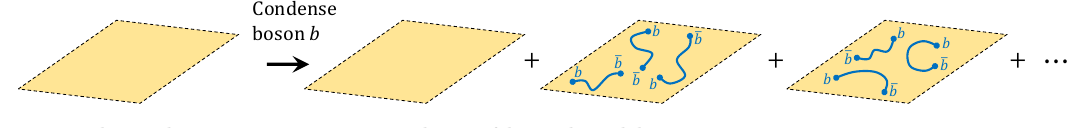
Figure 18: Condensation of the boson b . Given an anyon theory a boson b ∈ by proliferating the particles b in the space. The blue lines are short A string operators creating the boson b and its anti-particle ¯ b . In this manuscript, we will condense the boson b that is abelian (quantum dimension 1) and has its inverse ¯ b ( b × ¯ b =